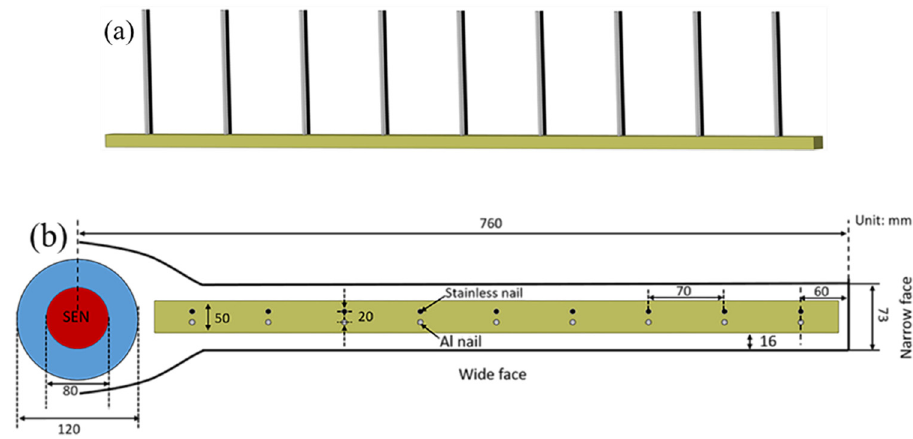
Figure 17: Description of the nail board and position for dipping tests: ( a ) nail board and ( b ) position for dipping